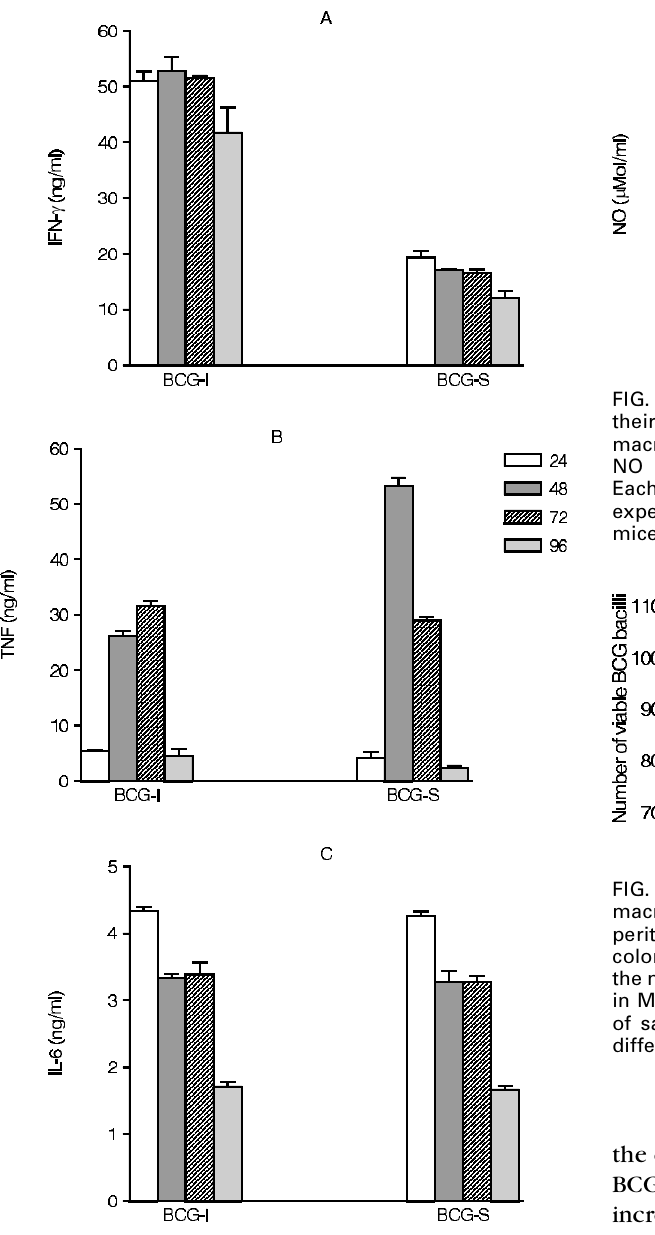
FIG. 2. Cytokine released by peritoneal macrophages from BALB/c mice. Mice were sacrificed and their peritoneal macrophages were collected. Peritoneal macrophages were stimulated in vitro with 100 m g of BCG lysates and at different time intervals the supernatants were collected. Tumour necrosis factor activity was assayed by measuring its cytotoxic activity on L-929 cells, whereas interleukin-6 and interferon- g were assayed by enzyme-linked immunosorbent assay using monoclonal antibodies as the probe. Each point represents the values of samples from five experiments ± standard deviation in different groups of five mice.